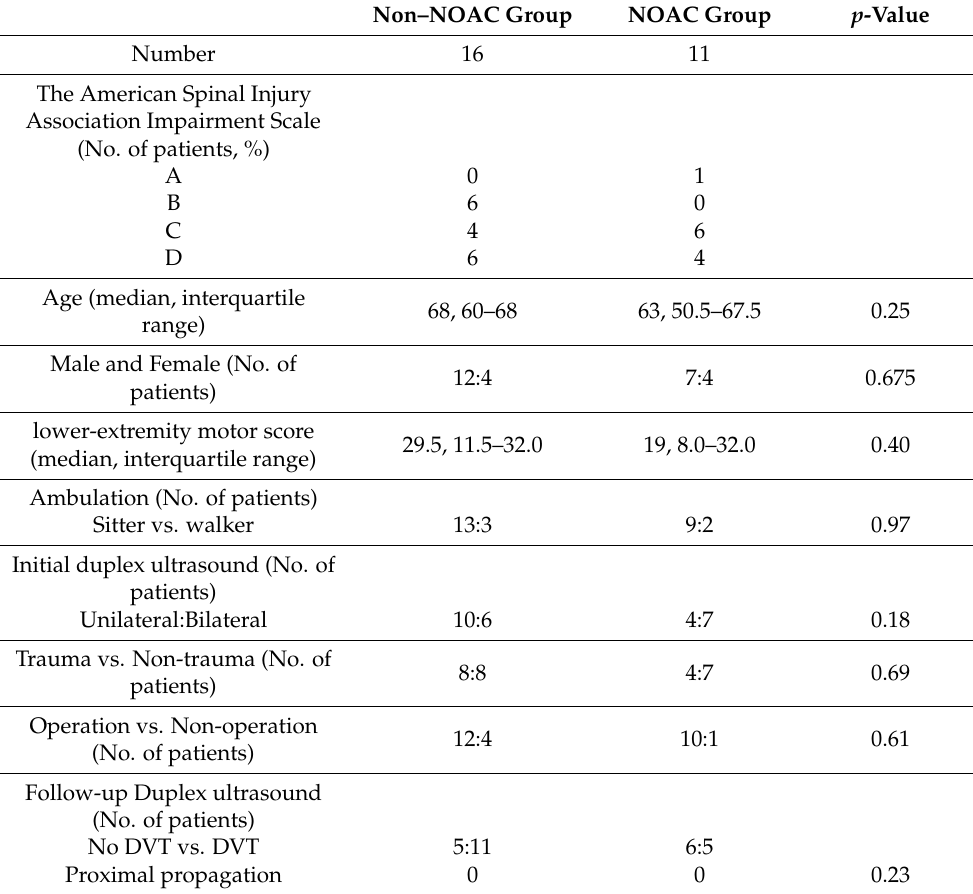
Table 2. Differences between anticoagulation